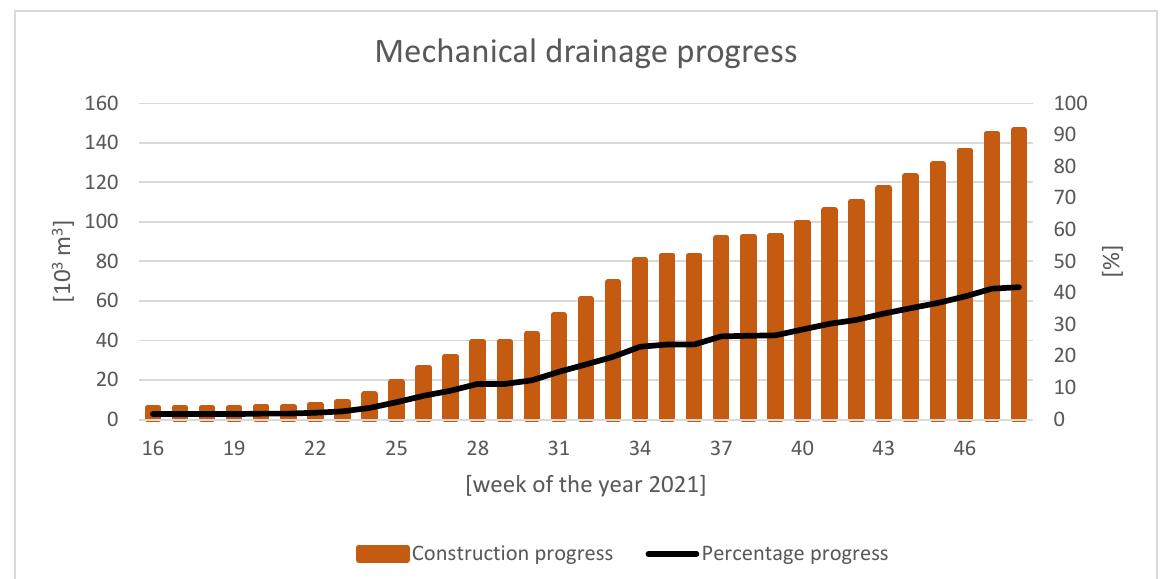
Figure 6. Construction and percentage progress of mechanical drainage of Category I soil (internal analysis based on reports of the project contractor).